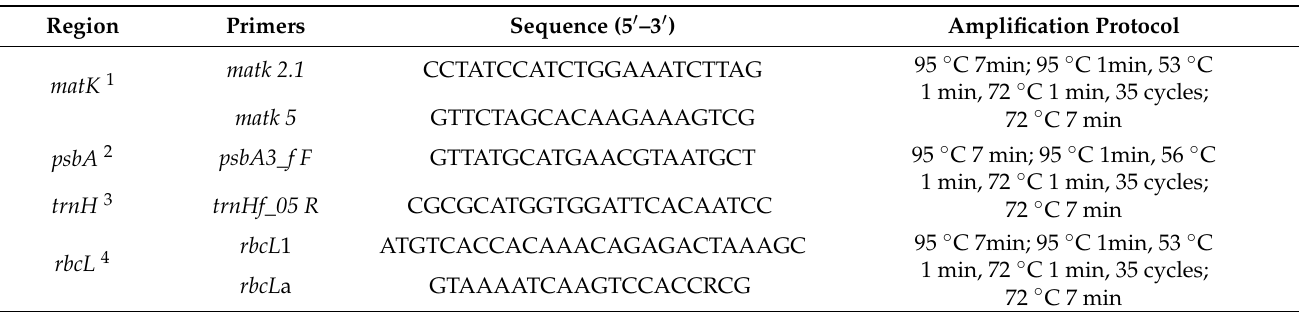
Table 4. Primer sequences applied in DNA amplification of Cinnamomum verum species and its experimental conditions.